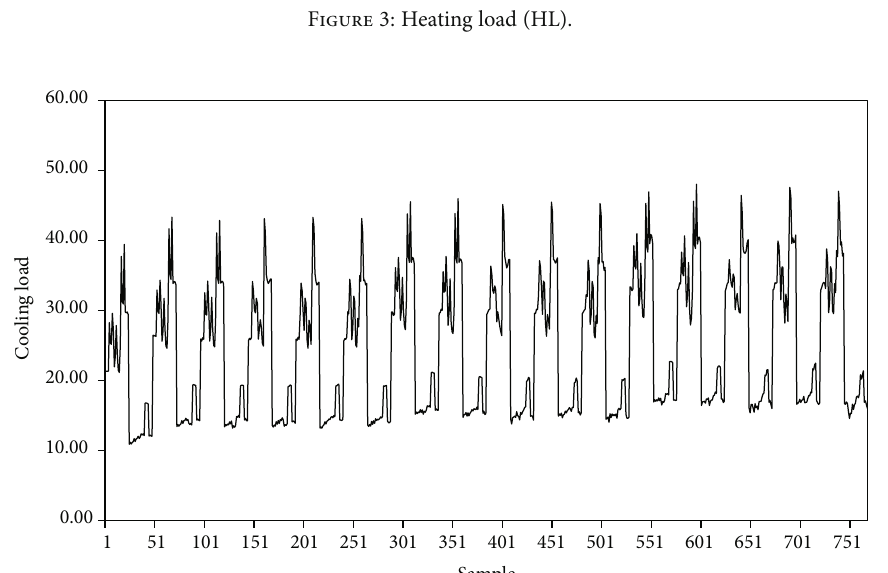
Figure 4: Cooling load (CL).